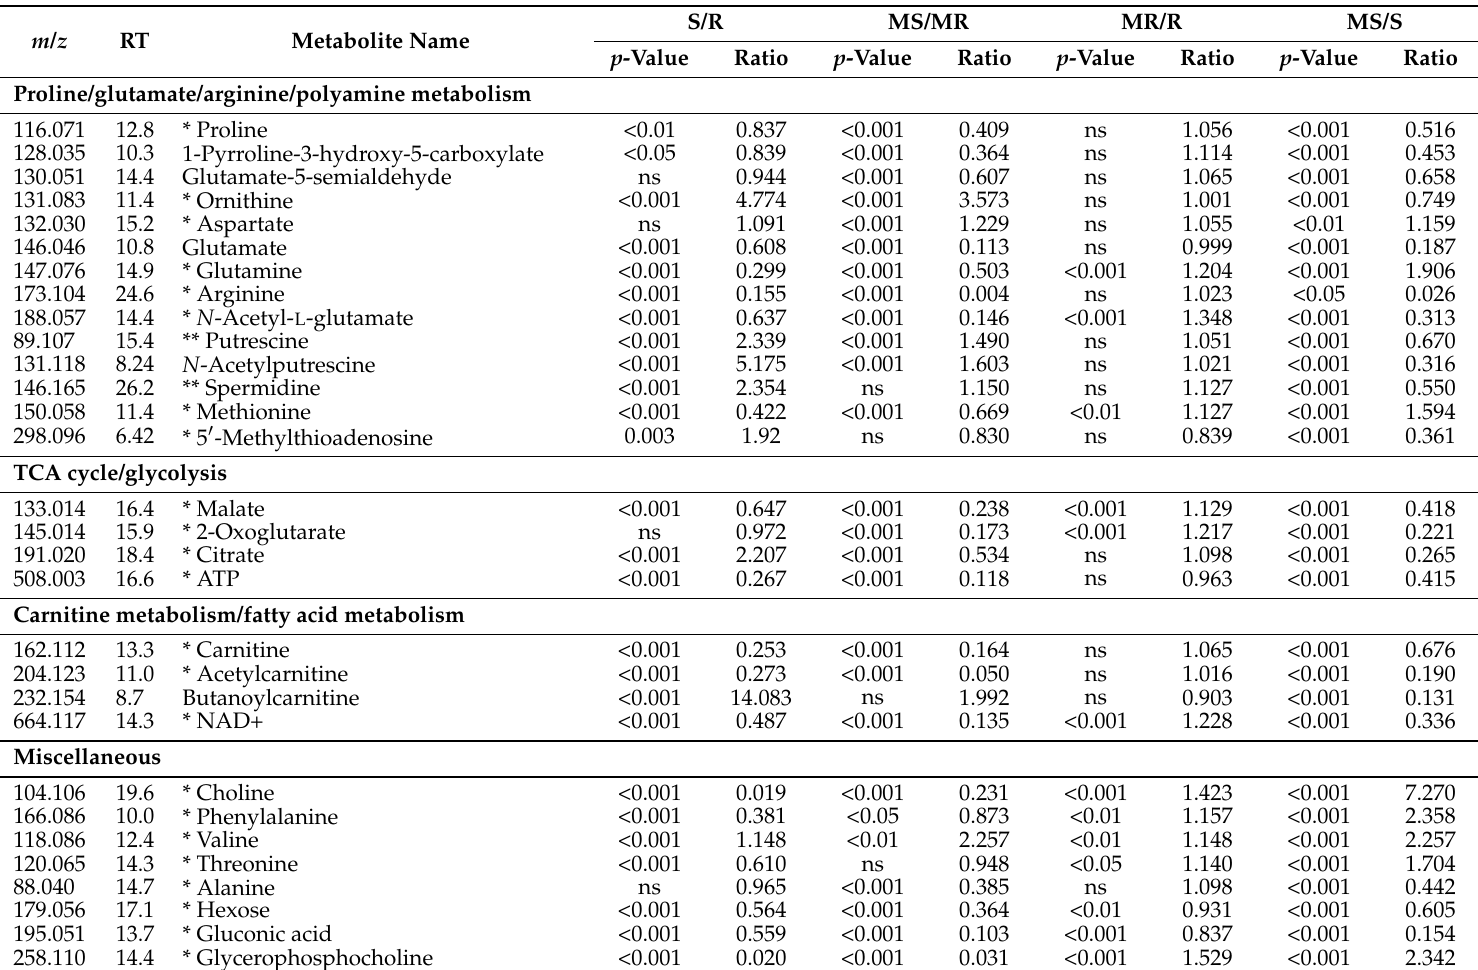
Table 1. Statistically differentiating metabolites in melittin treated and untreated A2780 and A2780CR